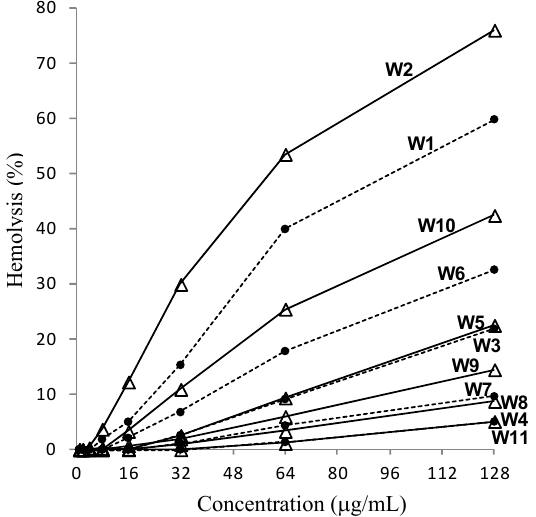
Figure 2. Hemolytic activities of the L K W n model peptides. Human red blood cells were 5 5 treated with individual peptides at various concentrations and hemolysis extents (%) are plotted along the peptide concentrations. Amino acid sequences are represented by the corresponding model numbers (refer to Figure 1).